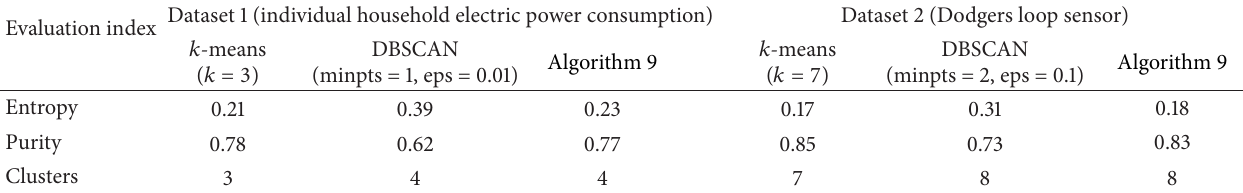
Table 4: Performance comparison among the